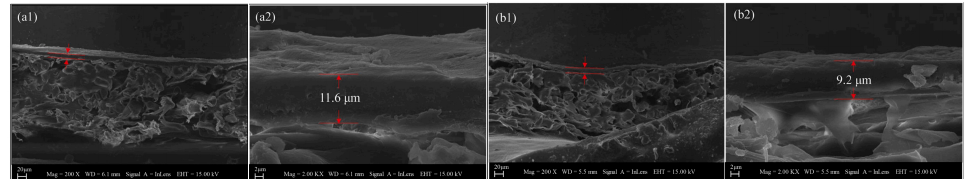
Figure 5. Low- ( left ) and high-magnification ( right ) scanning electron microscopy images of ( a1 , a2 ) ex- tracellular polymer-cake and ( b1 , b2 ) extracellular polymer-cake-Pb cross-sections